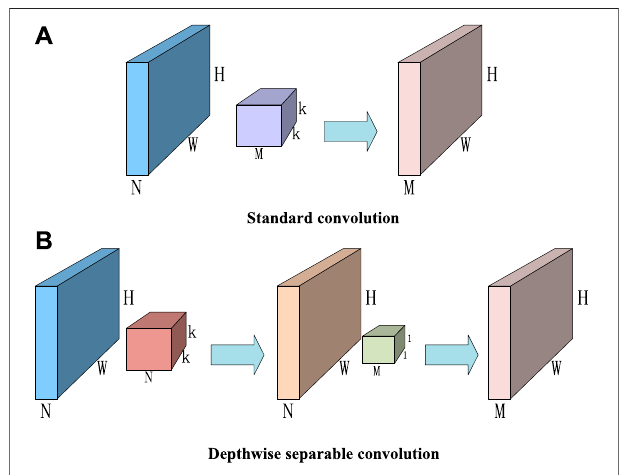
FIGURE3| Standardconvolutionanddepthwiseseparableconvolution. (A) Standard convolution. (B) Depthwise separable convolution.